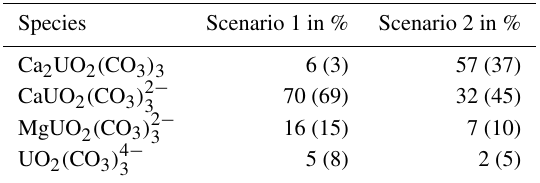
Table 2. Percentage of uranium species in the pore water of the shaly facies for the Scenario with logk = 29 . 22 (Scenario 1) and for the value of 30.55 (Scenario 2). Values of the sandy facies are given in